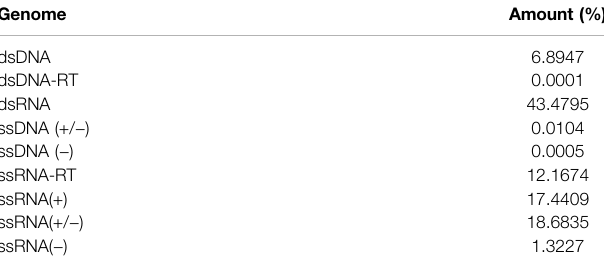
TABLE 1 | Summary of rate of viral sequences by genome type. Genome